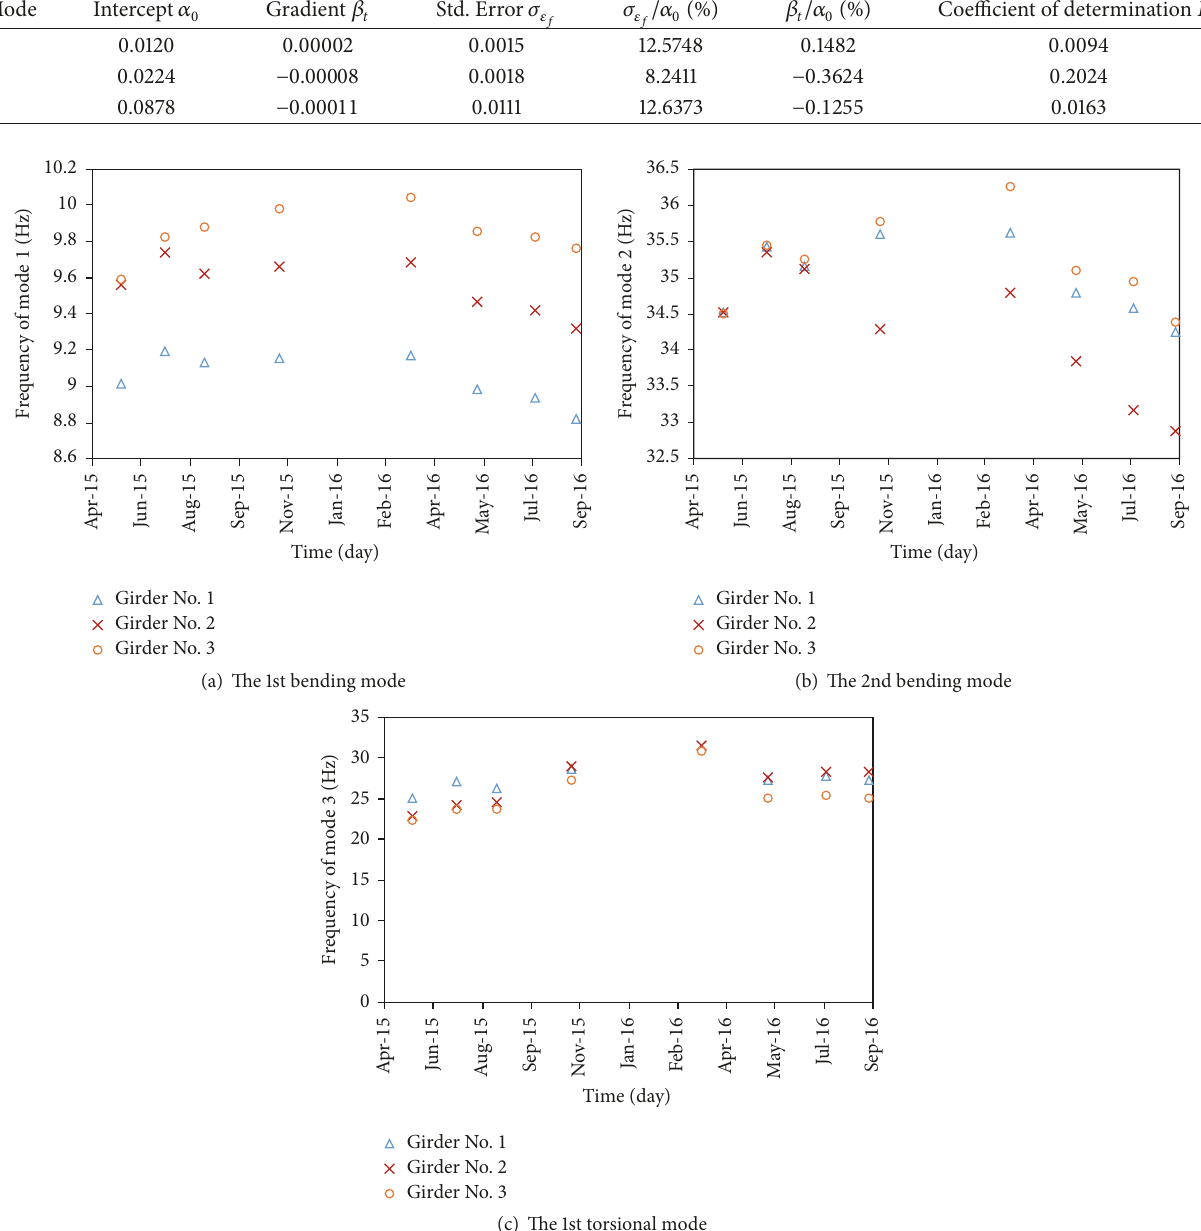
Figure 13: ((a)–(c)) Difference in natural frequencies of three